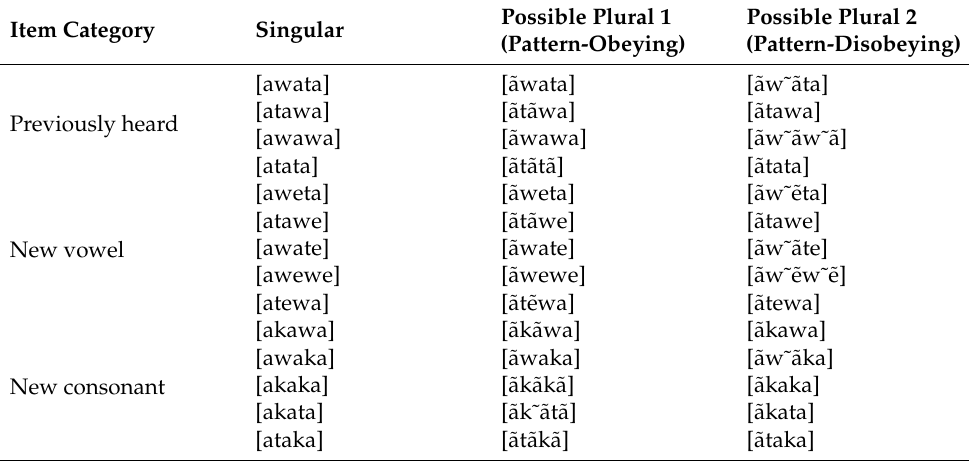
Table 7. Test stimuli presented to the group exposed to the unnatural